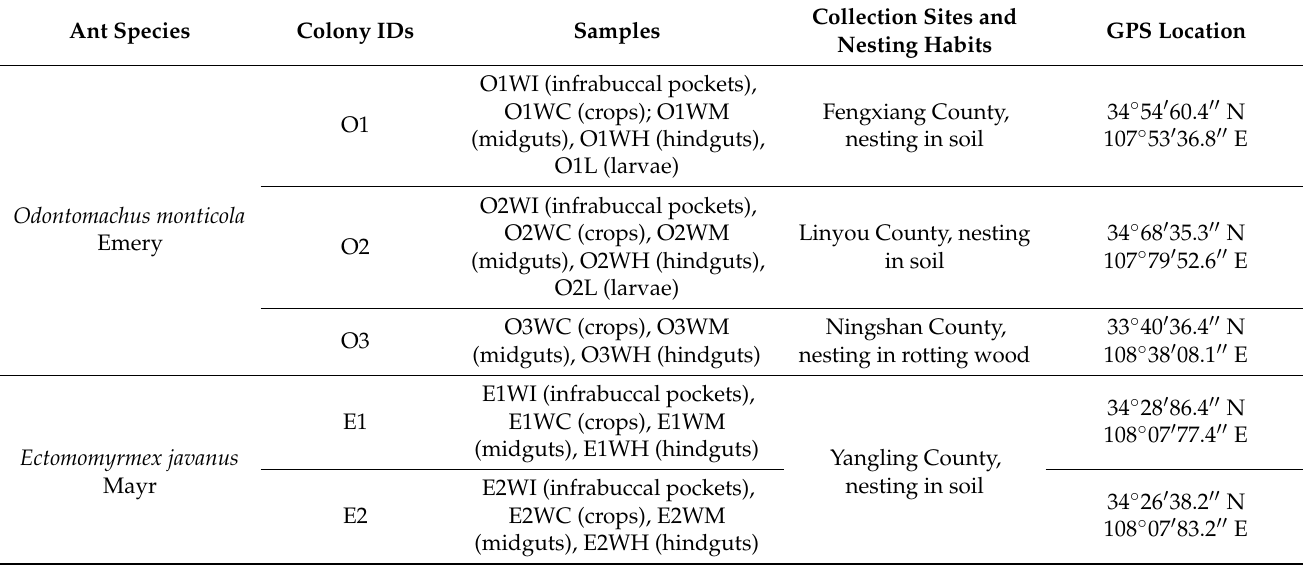
Table 1. Information of 63 samples from the two ponerine ants in this